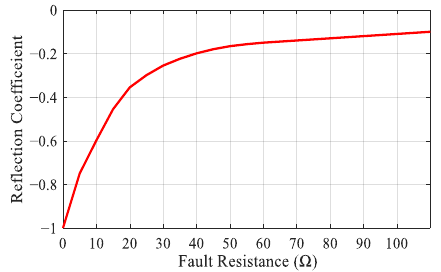
Figure 2. Function of fault current and the reflection coefficient at the fault point.